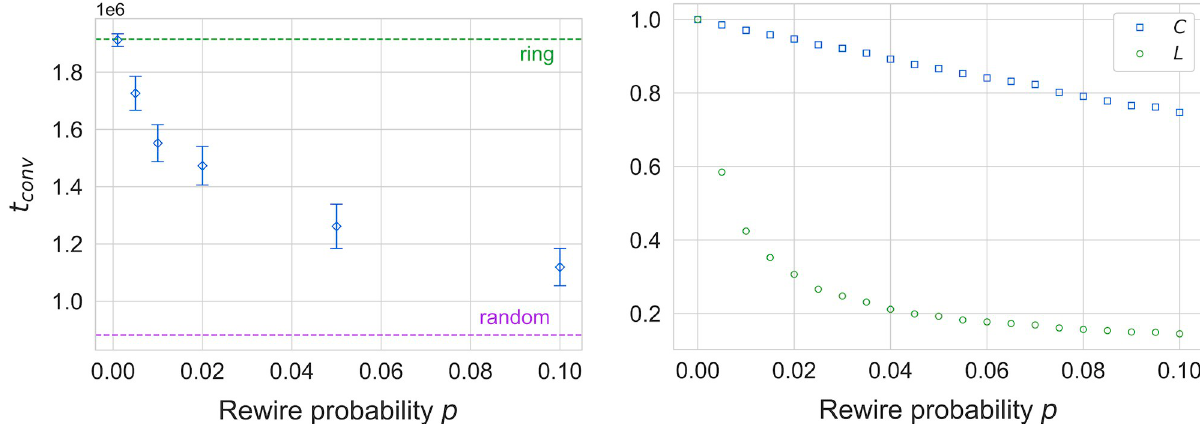
Fig 4. Scaling of convergence time t (left) and network properties (right, average clustering C and average shortest path length L ) for small- conv world networks, generated using the Watts-Strogatz model [44]. Average clustering C is defined as the average number of triangles, out of all possible triangles, that pass through a node, averaged over all nodes. Average shortest path length L is defined as the length of the shortest path connecting any two nodes on the network, averaged over all nodes. The convergence times of ring graphs and random networks are given, showing that small-world graphs approach the behavior of random networks as p increases, as expected. This is more likely a result of shorter average paths, which decrease sharply with an increase in p , while average clustering changes much more slowly for the same range. Results are for N = 400. Convergence times are averaged over 30 simulation runs each. Network properties are averaged over 50 network